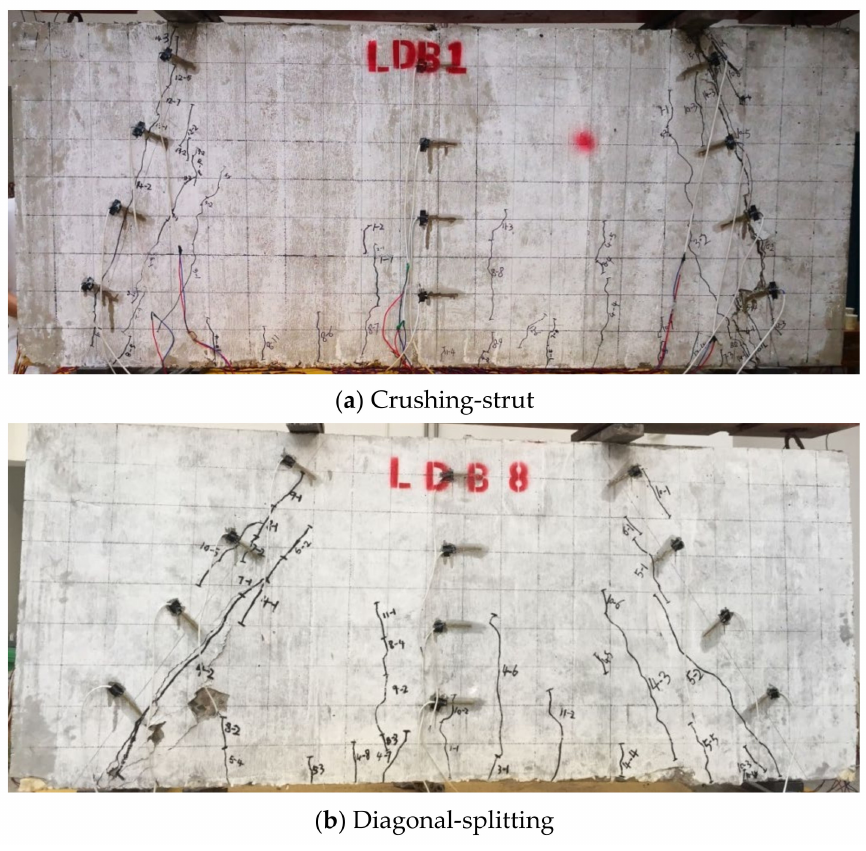
Figure 12. Failure mode of deep